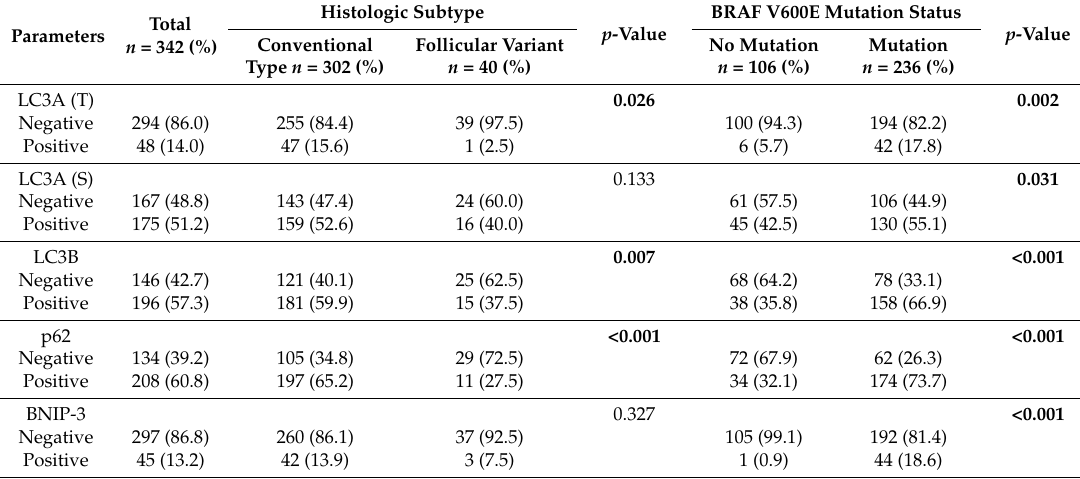
Expression of autophagy-related proteins according to histologic papillary thyroid carcinoma